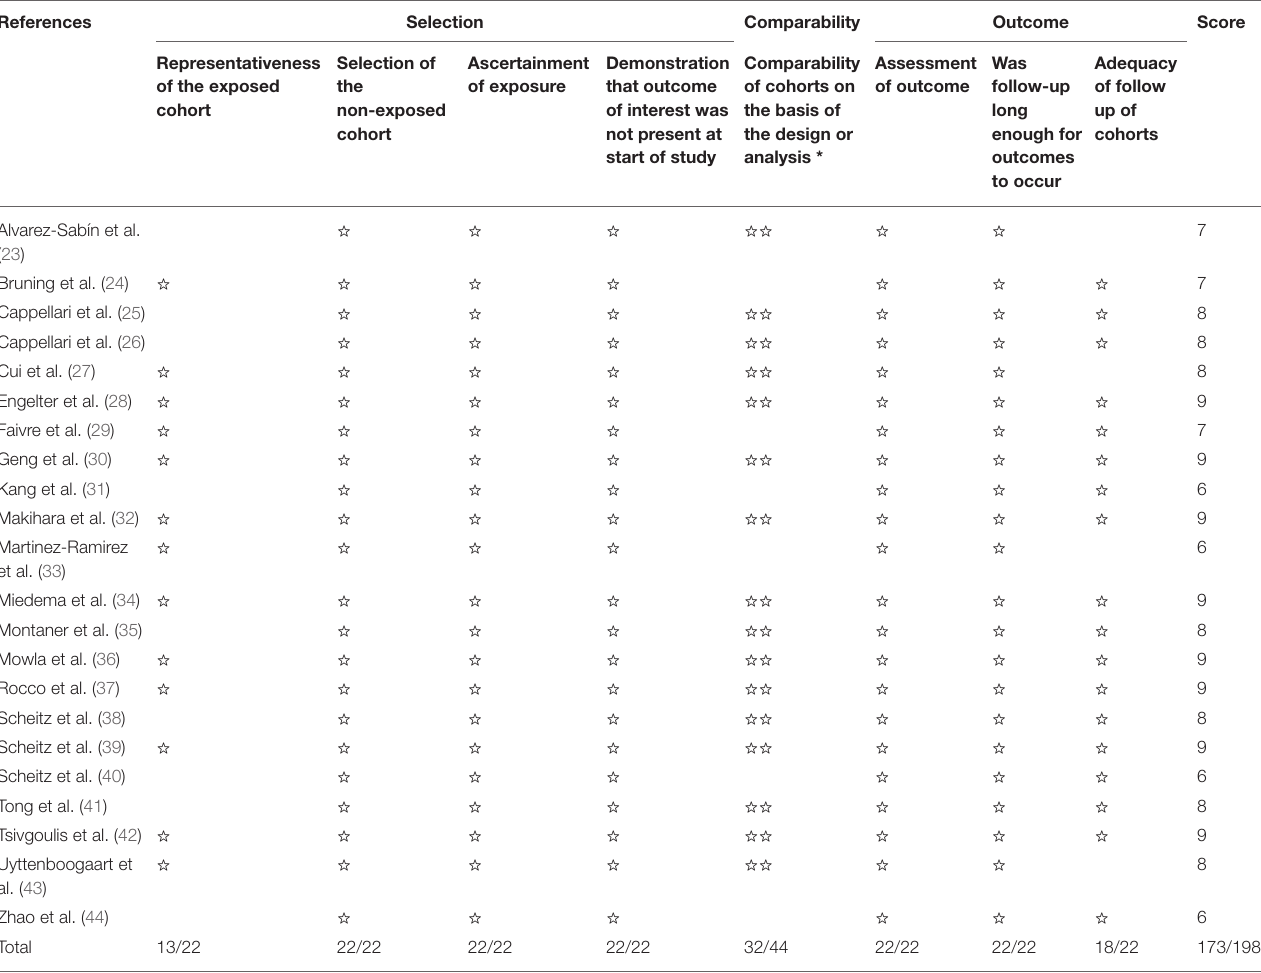
TABLE 2 | Risk of bias assessment.